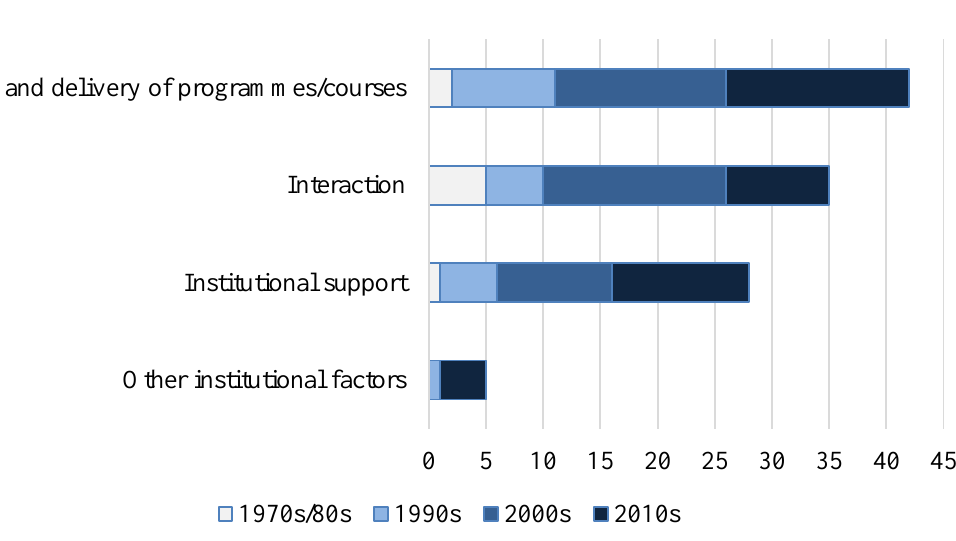
Figure 5. Frequency count of the subcategories of student factors in various periods. For institutional factors (Figure 6), those related to the design and delivery of programmes and courses were the most frequent, with this growth in frequency being substantial, particularly in the 2000s and 2010s. The factors related to interaction and institutional support also demonstrate a very significant growth in the past two decades, which explains the increasing proportion of institutional factors among all the student persistence factors, as shown in Figure 4.